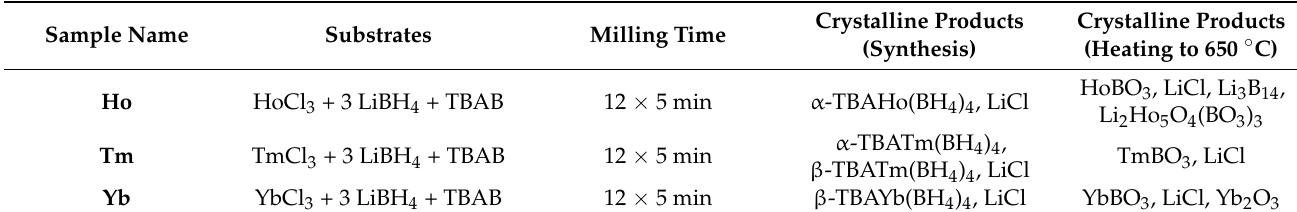
Table 1. Summary of the reactions of type (2) performed in this work, their conditions and crystalline products after the synthesis and after heating them to 650 ◦ C (and short contact with air 1 in the last case).